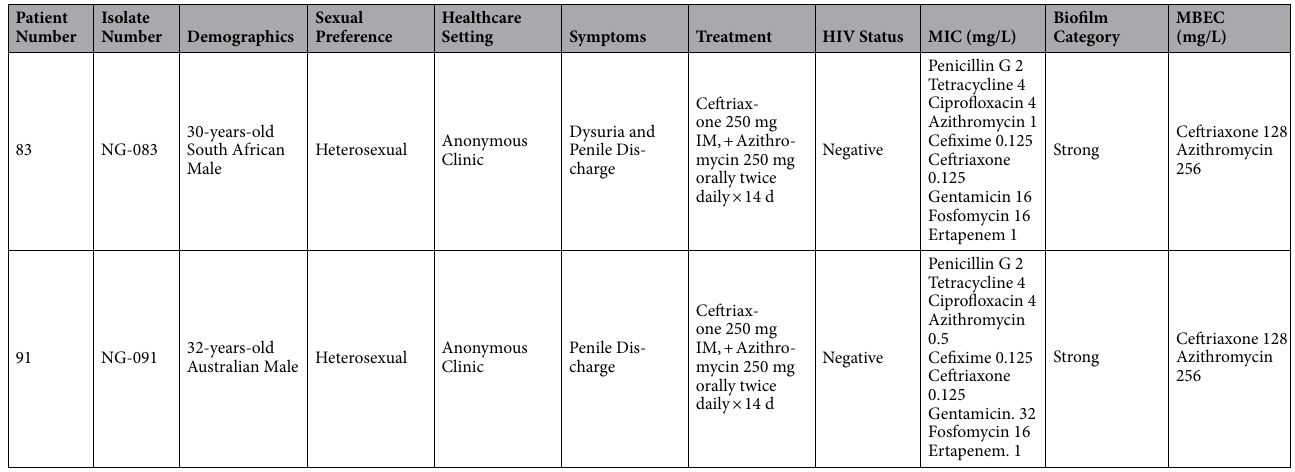
Table 1. Patients summery and antimicrobial susceptibility profile against the N. gonorrhoeae isolates with reduced susceptibility to ceftriaxone (n = 2), Thailand, 2016–2018. HIV human immunodeficiency viruses, MIC minimum inhibitory concentration, IM intramuscular, MBEC minimal biofilm eradication concentrations were categorized as responsive reaching about 90% of the total non-viable cells within a given antibiotic concentration range.